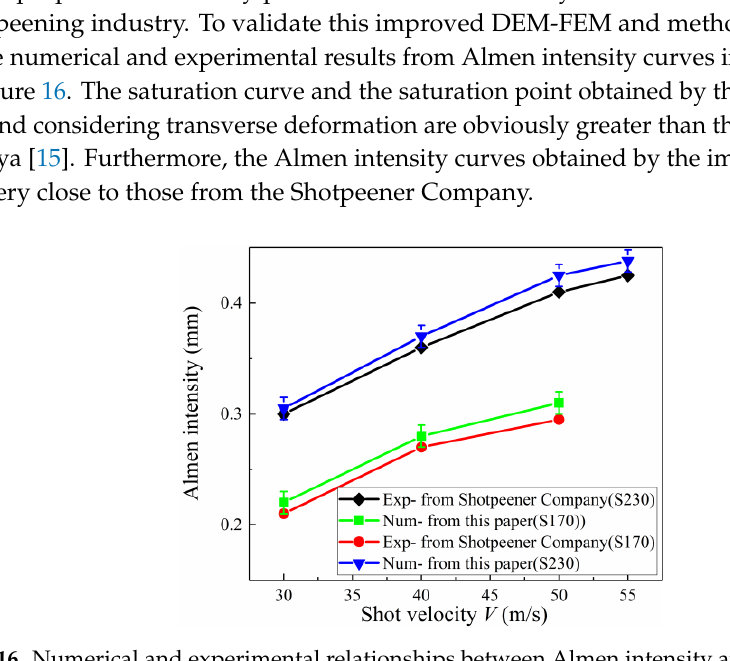
( b ) Figure 17. Removal constraints for the Almen strip. ( a ) “Sandwich” structure. ( b ) Comparison of the induced stress, residual stress from this paper and residual stress from Guagliano [16]. 5. Discussion The simulation method proposed in this paper further simulates the real Almen intensity test, which is not achieved by other traditional methods. The advantages are mainly reflected in the following aspects.